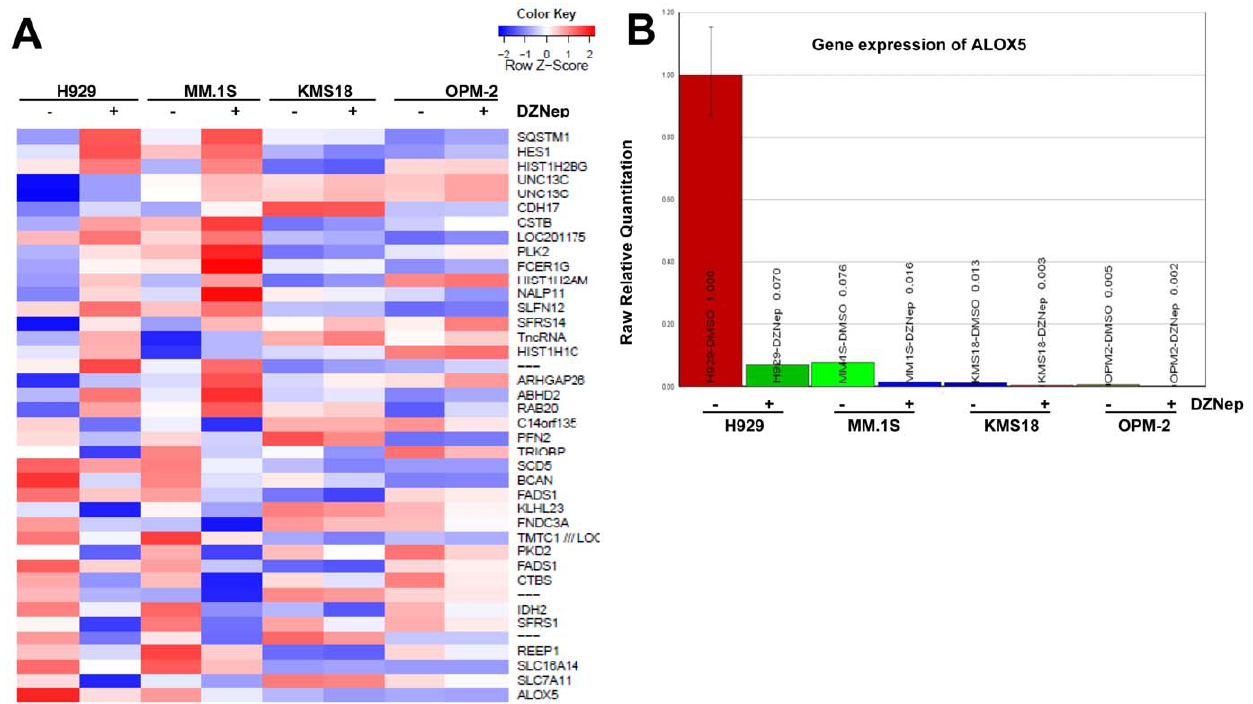
Figure 2. ALOX5 is differentially expressed in MM cells being sensitive to DZNep. Cells were treated with 0.5 m mol/L DZNep for 48 h. Total RNA was extracted using the Qiagen RNeasy Mini kit. (A) The cDNA microarray analysis was done to evaluate gene expression changes in response to DZNep treatment. Heat map showed the relative expression levels of the top 20 probe sets that were differentially expressed between DZNep- sensitive and DZNep-insensitive MM cell lines. ALOX5 was most down-regulated in DZNep-sensitive cell lines. Red, relatively high expression; green, relatively low expression. ( B ) Quantitative levels of differentially expressed ALOX5 . The ALOX5 was determined by quantitative RT-PCR. Colunms, mean; bars, SE. Average C T values were first normalized against the housekeeping gene b - Actin and converted to the induced fold change relative to the vehicle control.